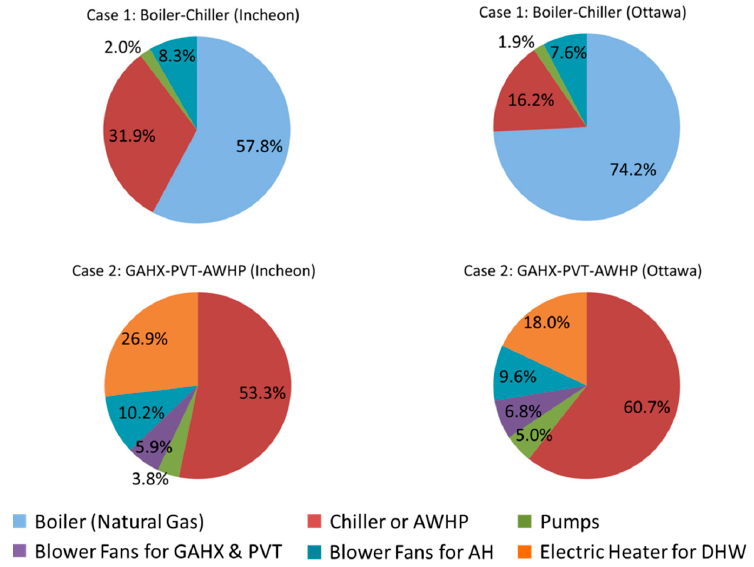
Figure 7. Distribution of primary energy consumption by components.